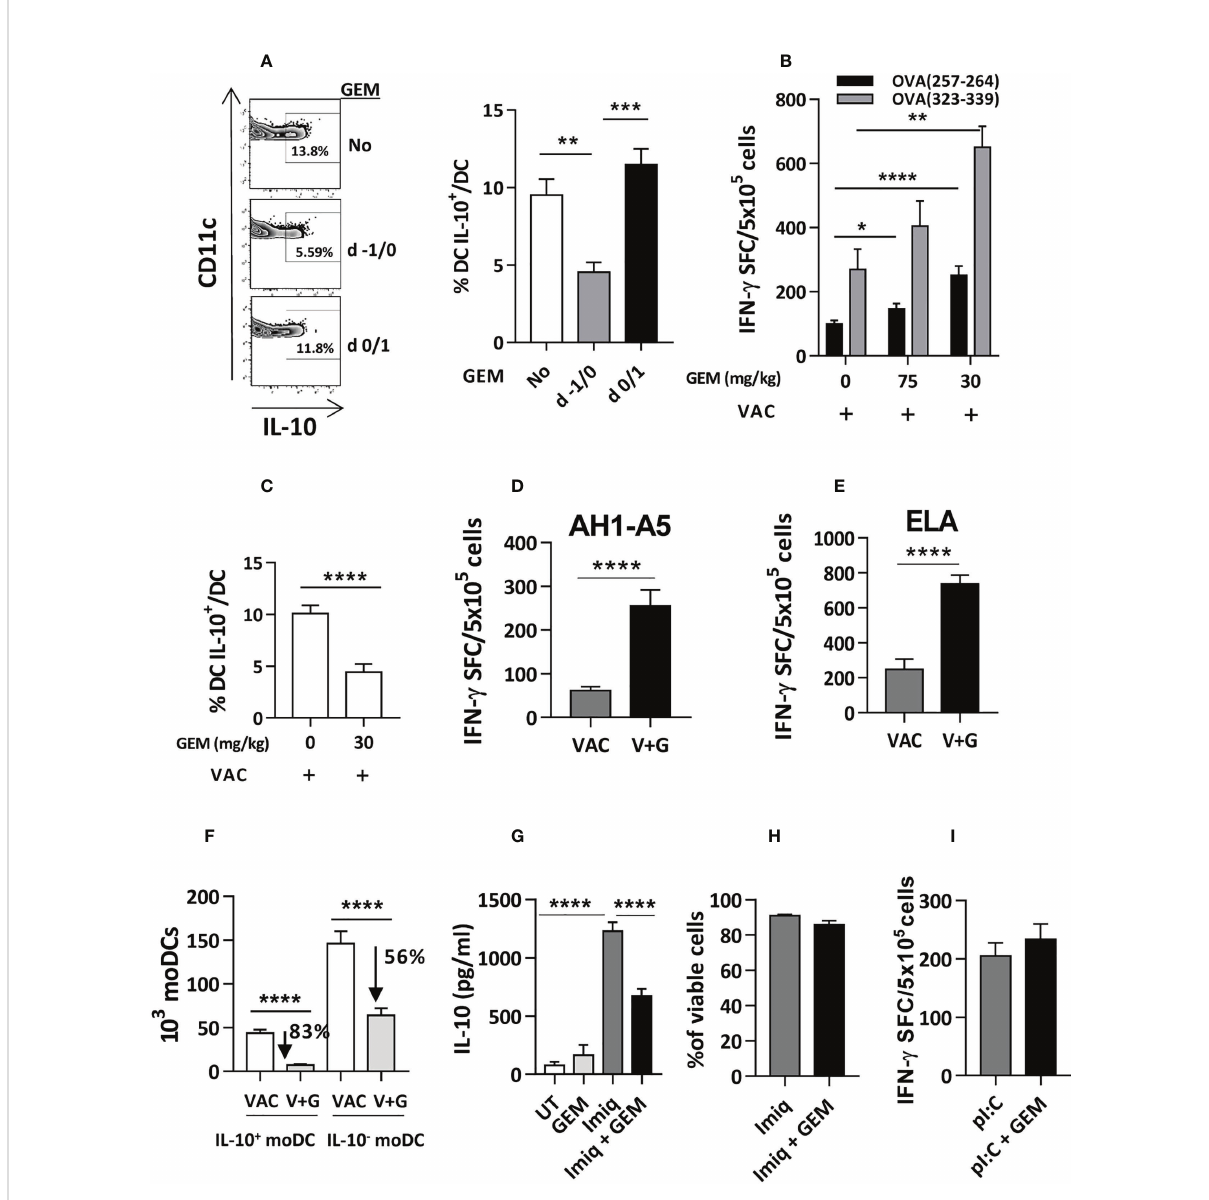
FIGURE 3 Gemcitabine administration reduces generation of DC IL-10 + and improves vaccine immunogenicity. (A) Gemcitabine (GEM) was administered to Vert-X mice (n=4-8/group) before (days -1/0) or during (days 0/1) vaccination with OVA and two days later the percentage of splenic DC IL- 10 + was measured. (B) Different doses of gemcitabine were administered to C57BL/6J mice (n=4-12/group) before vaccination with OVA (VAC) and responses against OVA(257-264) and OVA(323-339) peptides were determined by an IFN-gamma ELISPOT, measuring the number of spot forming cells (SFC). (C) Effect of administration of 30 mg/kg of gemcitabine on DC IL-10 + generation before vaccination (VAC) of C57BL/6J mice (n=12/group). (D) BALB/c or (E) HHD mice (n=4-7 mice/group) were vaccinated with peptide AH1-A5 or ELA, respectively (VAC) or received the vaccine plus gemcitabine (V+G). One week later responses against the immunizing peptides were determined by ELISPOT. (F) Effect of gemcitabine administration on the generation of DC IL-10 + and DC IL-10 - (n=12 mice/group) according to their monocytic origin. Bone marrow-derived DC were left untreated (UT), treated with Imiquimod, gemcitabine or both, and IL-10 secretion (n=12 wells/condition) (G) and cell viability (n=4) (H) were determined. (I) C57BL/6J mice (n=8-10/group) were immunized with OVA + poly(I:C) with or without gemcitabine and responses against OVA(257-264) peptide were determined by ELISPOT. Bars show mean + SEM (*, P < 0.05; **, P < 0.01; ***, P < 0.001; ****, P <